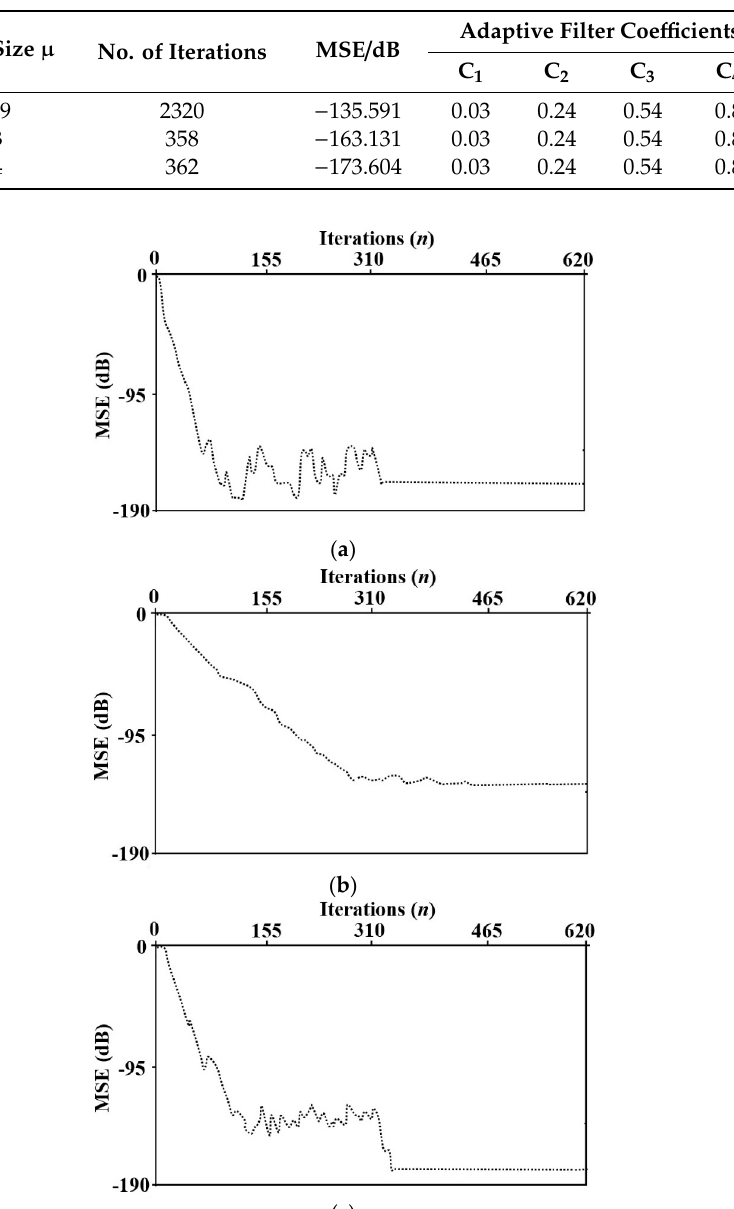
Table 2. Simulation results of the FIR adaptation (colored signal).